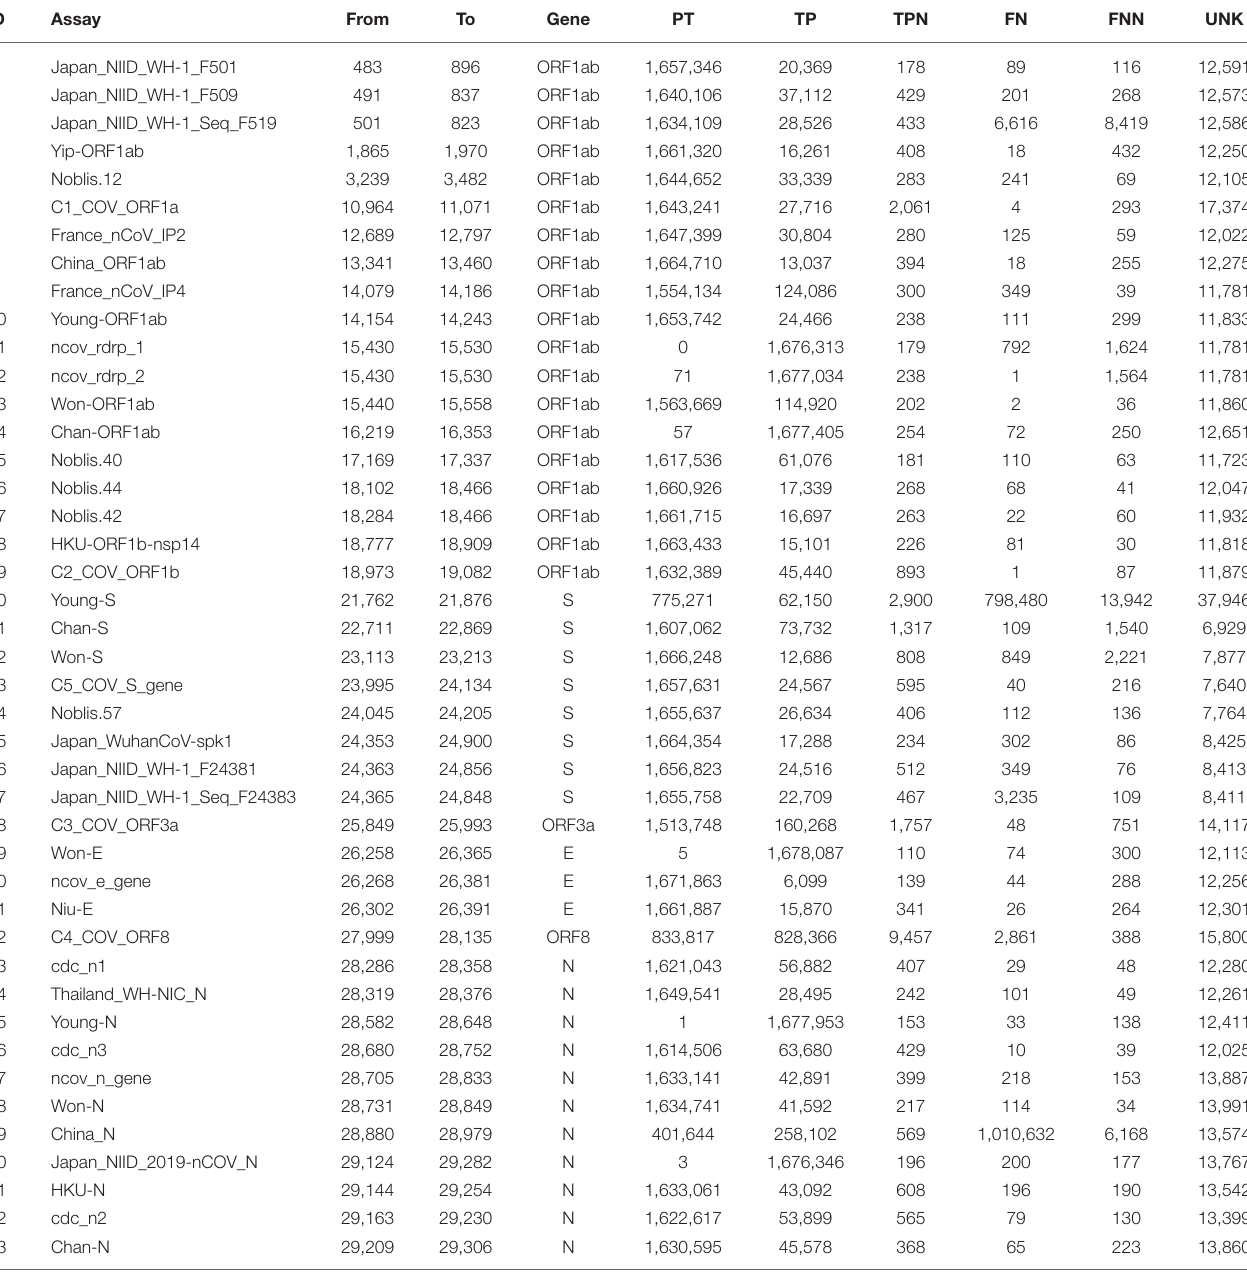
TABLE 1 | Confusion matrix of assay calls based on